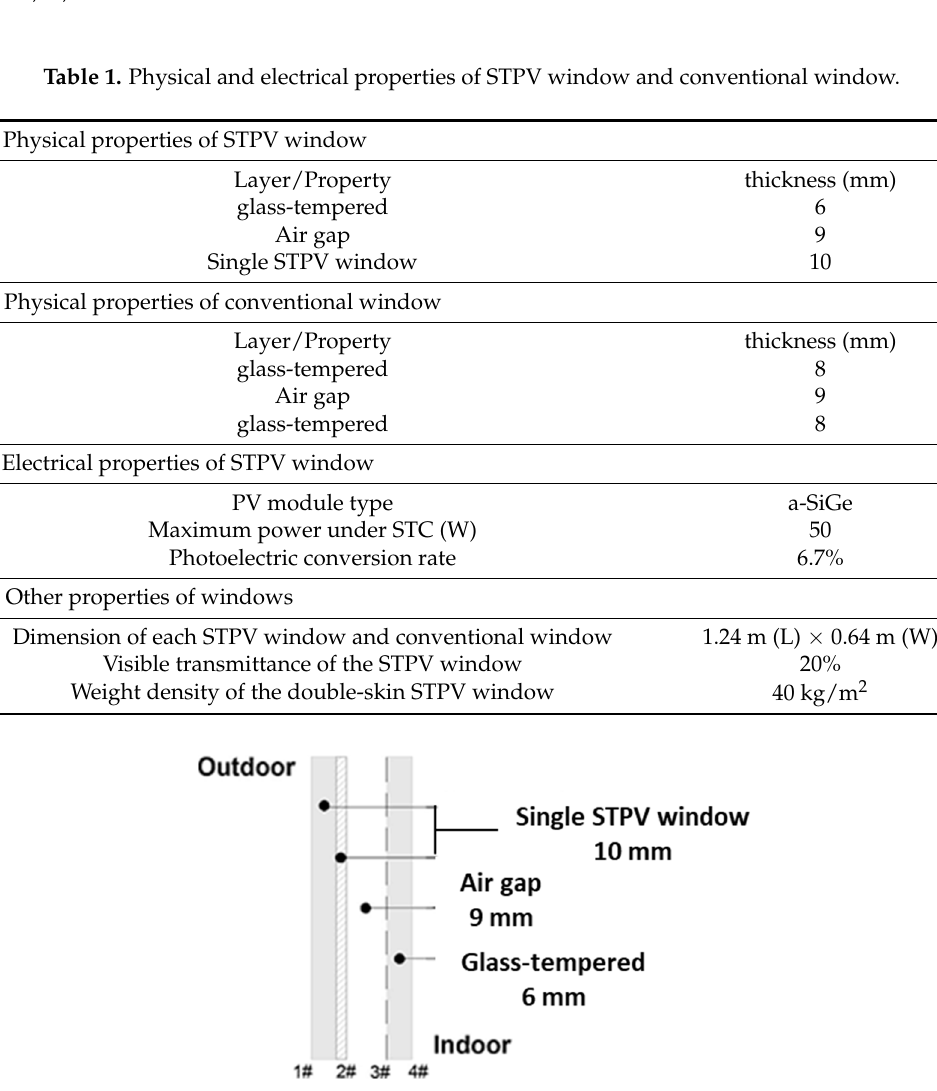
Figure 1. Schematic diagram of double ‐ skin STPV window.